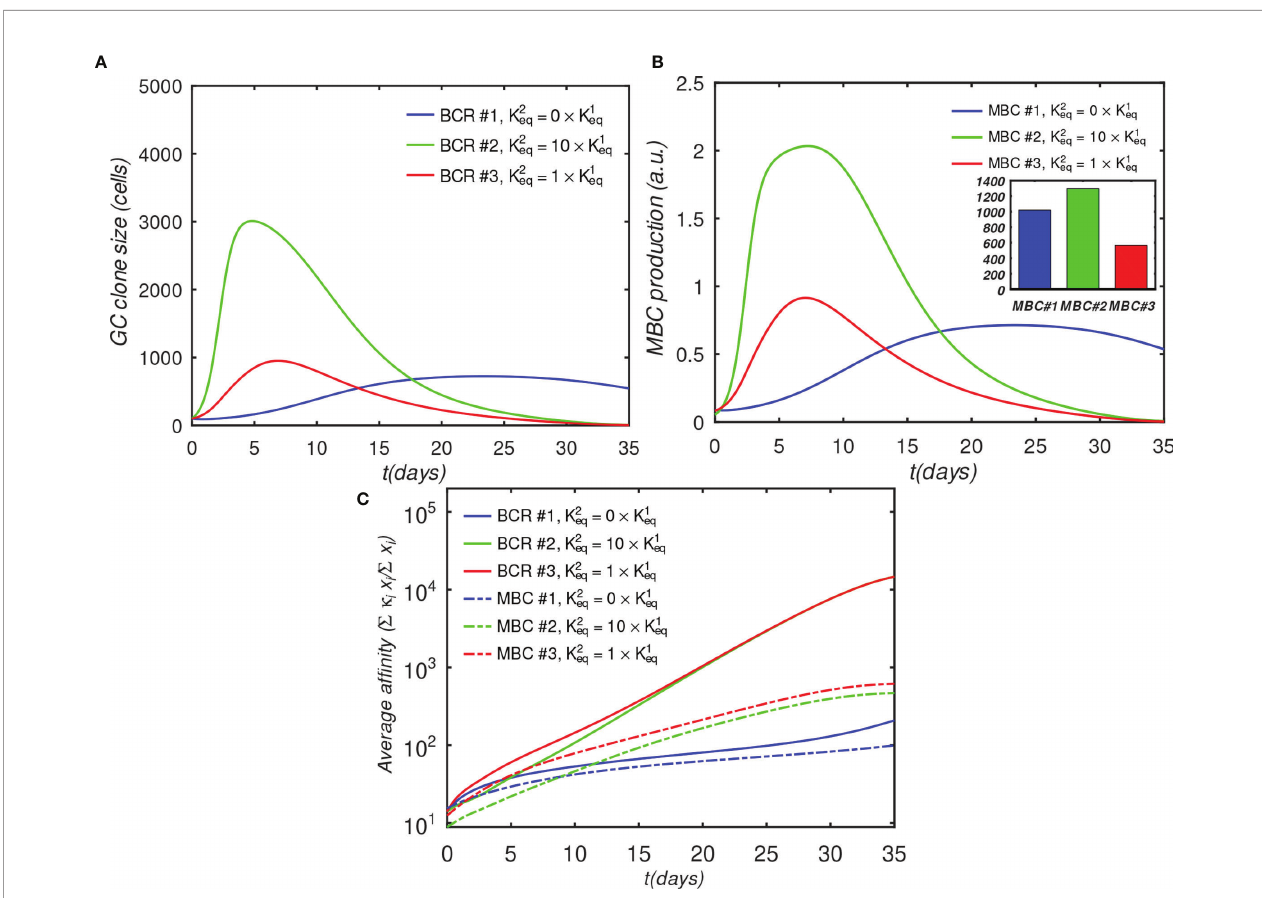
FIGURE 7 | Effect of BCR valency and epitope concentration on GC evolution, with o = 1 (fully competitive case). Panels (A – C) show the same quantities as Figures 4A – C ; a T 1 = 2, a T 2 = 1, a T 3 = 1; a T is the nondimensional total Ag concentration (see Sec. 4.1.6